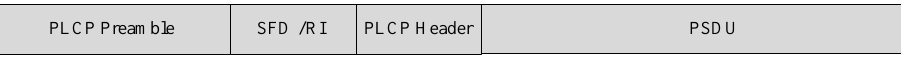
Figure 3. PPDU structure for HBC PHY.